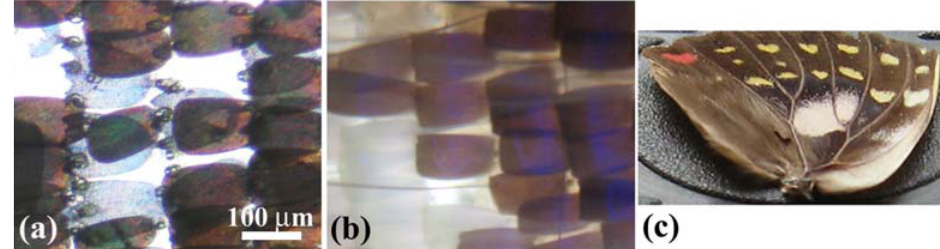
Figure 5. ( a , b ) OM images of scales on the border between the purple-blue iridescent area and white patch in a forewing of the male S. charonda . Transmission image ( a ) and reflection image ( b ); ( c ) The hindwing taken at a low glancing angle under sunlight (adapted from